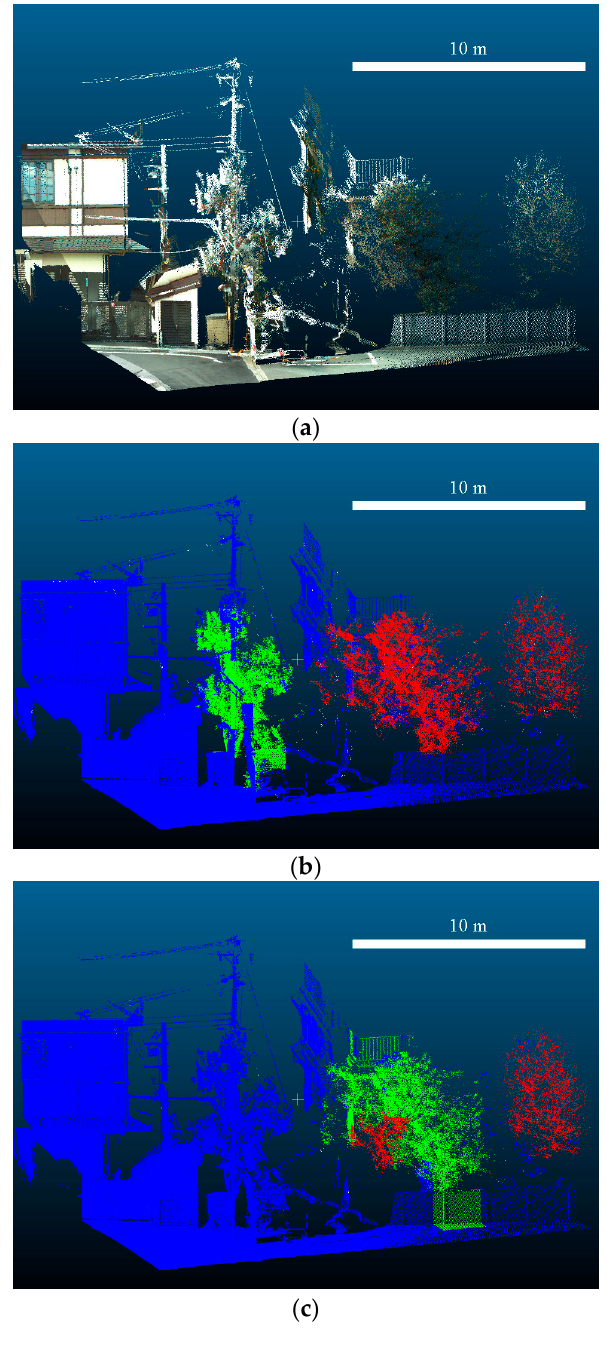
Figure 9. ( a – c ) Improvement of extracting vegetation based on a multi-spatial-scale approach. See Figure 8 for a description of each panel.